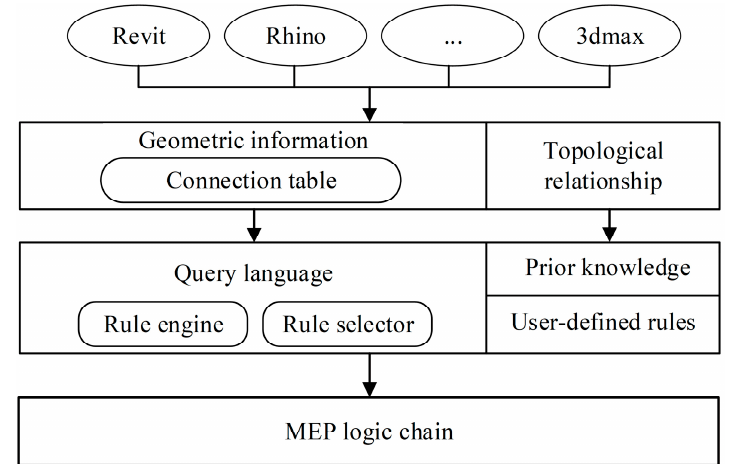
Figure 2. The foundations of automatically generating MEP logical relationships. MEP: Mechanical, Electrical, and